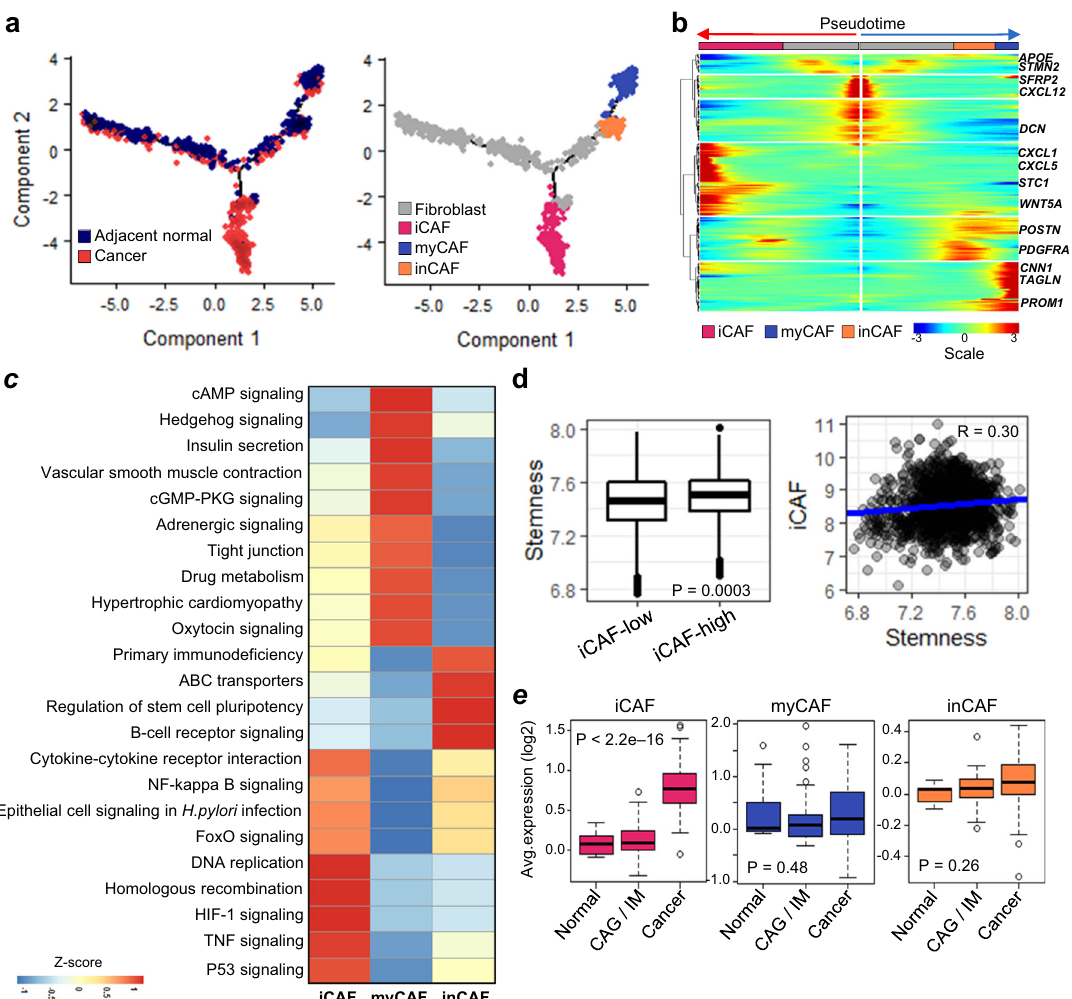
Fig. 5 Cancer-associated fi broblast (CAF) heterogeneity and pro-stemness in gastric cancer. a Trajectory trees of CAF reconstructed using annotated fi broblasts and endothelial cells. Colors correspond to the malignancy (left) and CAF types (right). b Heatmap plot showing expression of signi fi cantly variable genes ( P < 1.0e – 05; likelihood ratio test) and known CAF markers. Collected cells (columns) are sorted by pseudotime, and the genes (rows) are clustered by hierarchical clustering. c Hallmark pathways of the CAF subtypes determined by enrichment analysis. Signi fi cance was determined by the R package limma (adjusted P < 0.05). d Box plot of the stemness score in bulk RNA metadata (left), and correlation between iCAFs and the stemness scores (right). e Boxplots of CAF marker gene expression patterns plotted using bulk RNA data (GSE2669), according to the gastric diseases progression cascade (i.e., normal, premalignant, Intestinal Metaplasia (IM) or chronic atrophic gastritis (CAG), and cancer). P values were calculated by